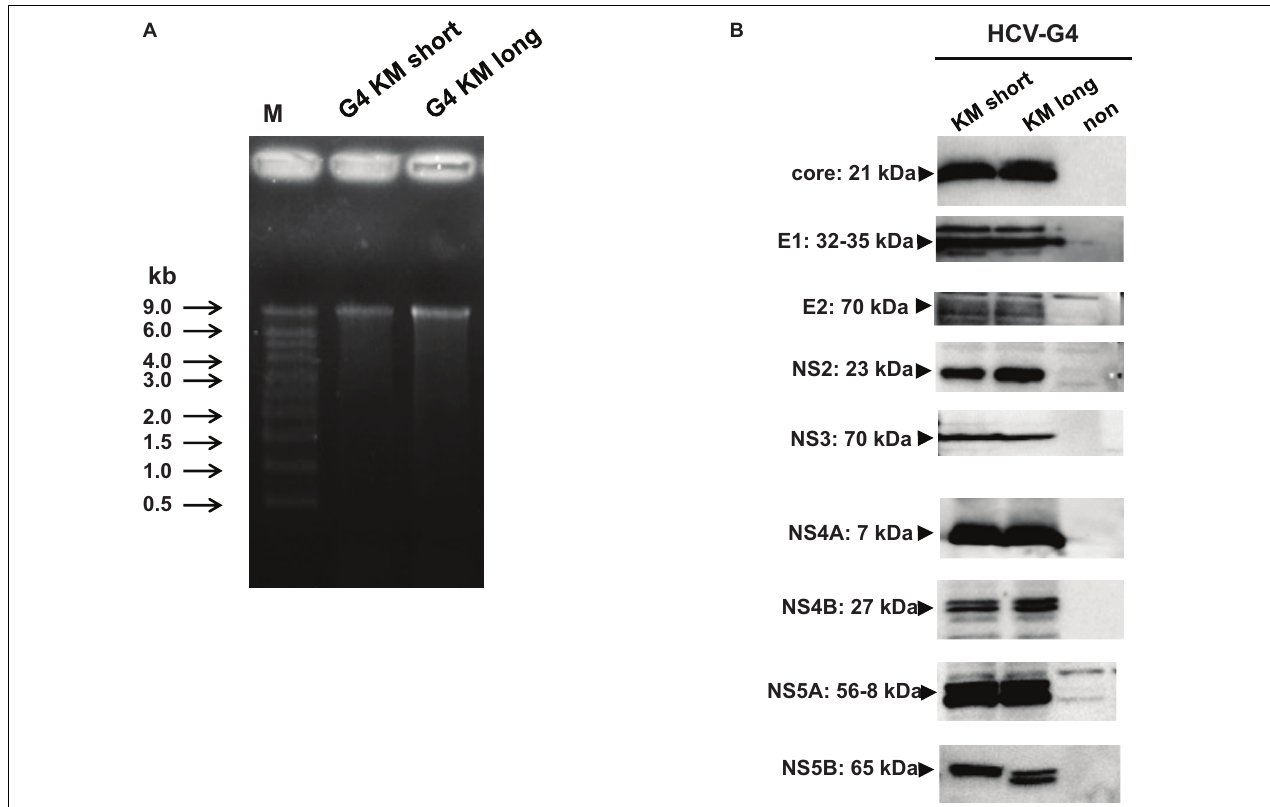
FIGURE 4 | Expression of HCV-G4 KM short or HCV-G4 KM long clone in vitro . (A) Transcripts of HCV-G4 KM short or HCV-G4 KM long (1 µ g/lane) were examined in a formamide agarose gel. (B) Detection of HCV proteins in HCV-G4 KM short or HCV-G4 KM long-expressing cells, which was induced by infection with T7 RNA polymerase encoding vaccinia virus. Representative results of three experiments are shown.